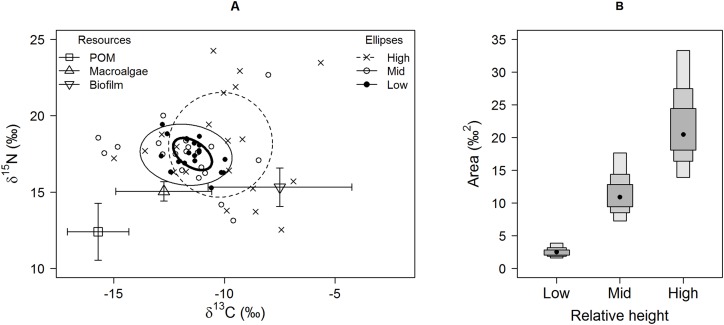
Isotopic variation among Echinolittorina peruviana individuals grouped by relative height on the shore.(A) Individual values on an δ15N-δ13C biplot, with standard ellipses (equivalent to a bivariate SD), corrected for small sample size (SEAc), plotted as calculated by the SIBER procedure (Jackson et al., 2011). Plot lines and symbols represent shore height (see legend). (B) E. peruviana isotopic niche width (SEA.B) at different shore heights, plotted with 95, 75 and 50% credible intervals and mode as a black point. Macroalgae includes Lessonia nigrescens, Dictyota sp. and Ulva sp. pooled.